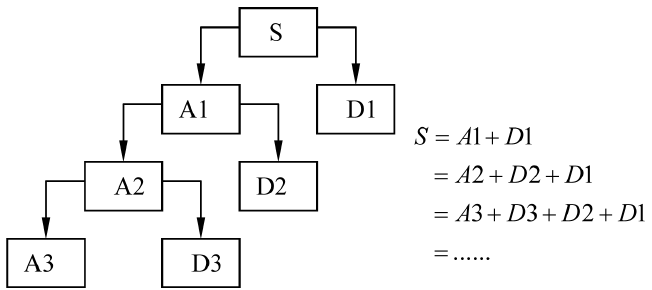
Fig. 7. Wavelet decomposition tree.